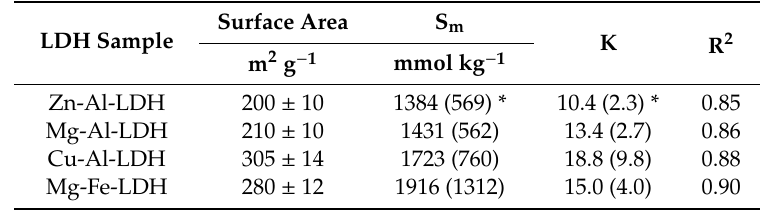
Figure 1. Powder X–ray diffraction patterns of Mg-Fe ( A ), Cu-Al ( B ), Mg-Al ( C ) and Zn-Al ( D ) layered double hydroxides (modified from Pigna et al. [24]). Table 1. Surface area, Langmuir maximum adsorption capacity (S m ), K value (K) and coefficient of determination (R 2 ), as obtained from As(V) adsorption isotherms onto the four layered double hydroxides